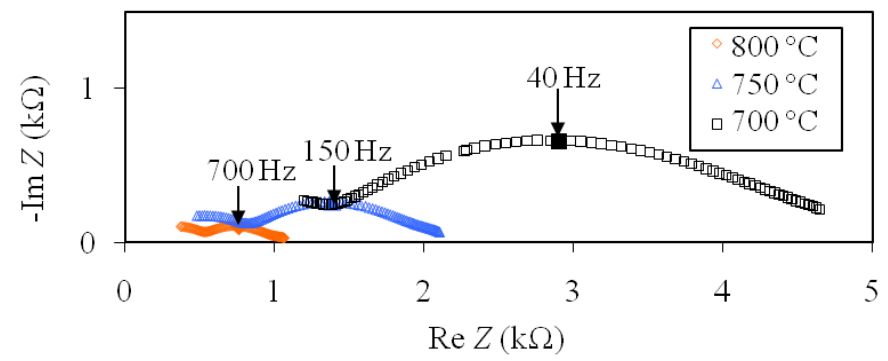
Figure 5. Impedance spectra of the bulk SZY membrane exposed to p O 2 (air) / p O 2 (Ar) gradient. p H 2 O(air) = p H 2 O(Ar) = 3365 Pa.